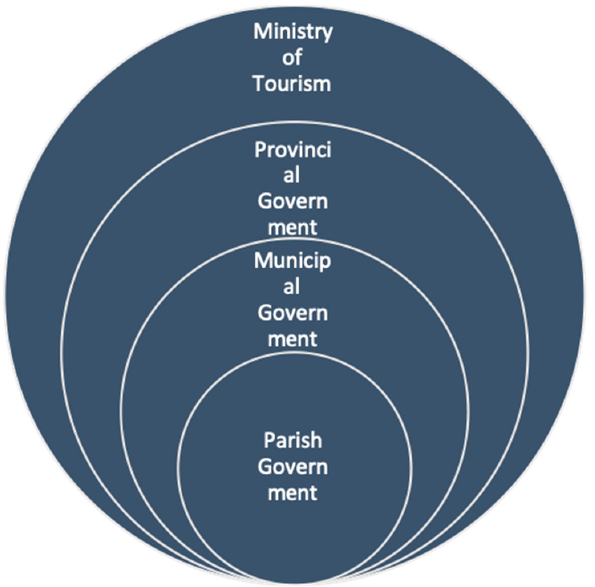
Figure 4. Hierarchy and institutional competence of tourism in Ecuador.